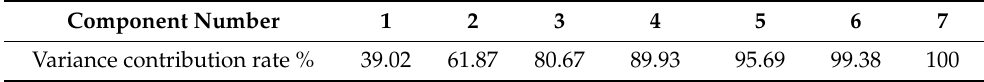
Table 3. Calculation of cumulative variance contribution rate.